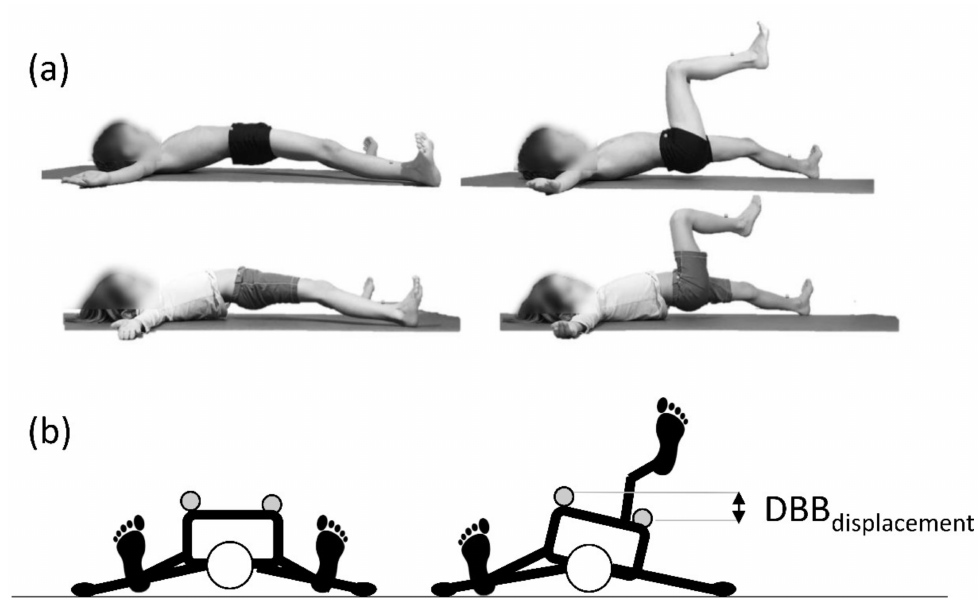
Figure 1. Lateral ( a ) and cranial ( b ) views of the deadbug bridging (DBB) exercise in ( left ) the initial position and ( right ) the maximum leg lift phase. Participants performed the leg lift sequence three times without the hip touching the ground. Markers are placed on clothing for the picture but are for actual testing placed on the